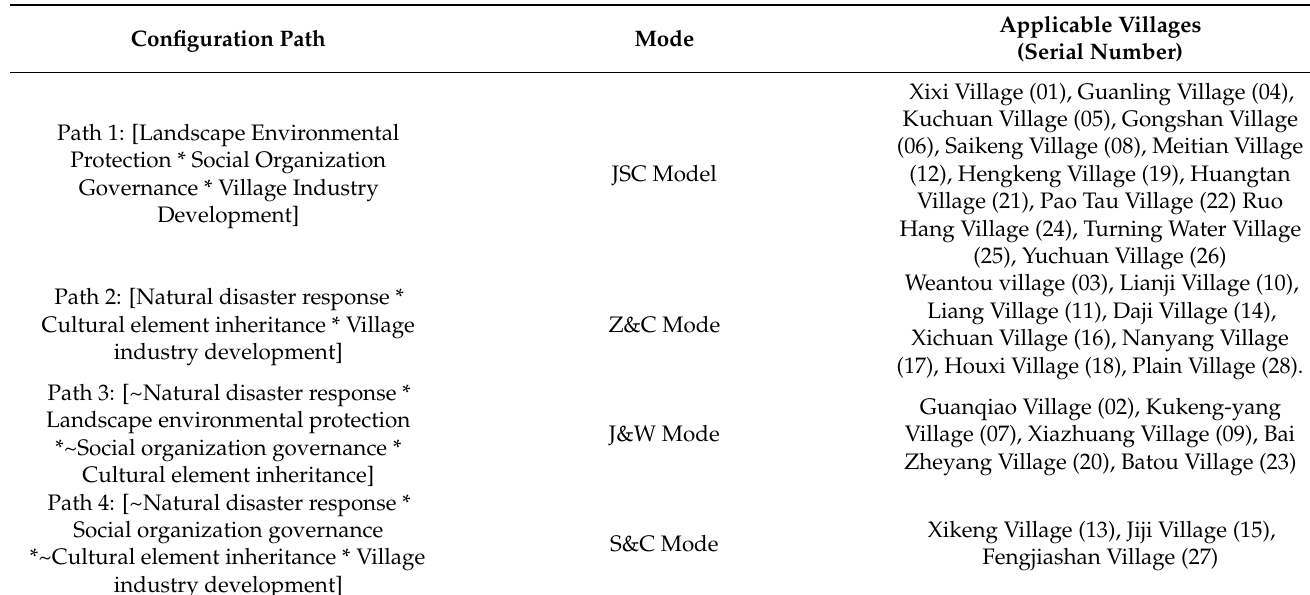
Figure 7. Protection and development framework of traditional villages from the perspective of resilience theory. Table 13. Protection and development model of traditional villages.